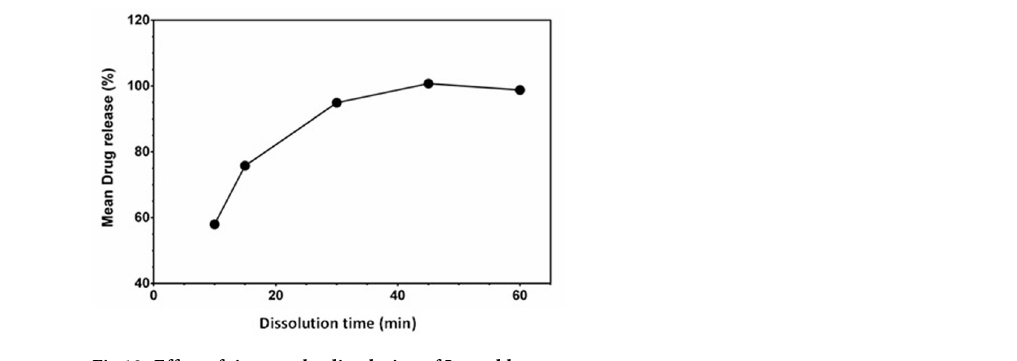
Fig 10. Effect of time on the dissolution of Lap